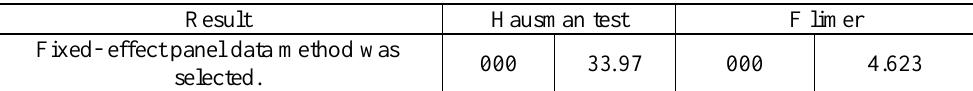
F limer Hausman test Result